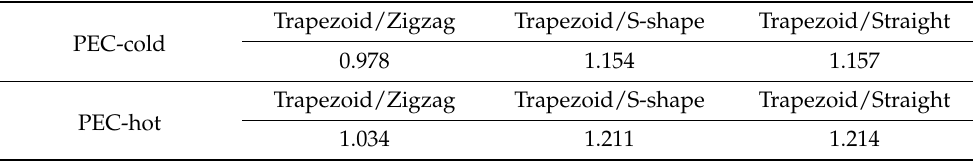
Table 5. The PEC data of four channel structures in both the cold and the hot sides.